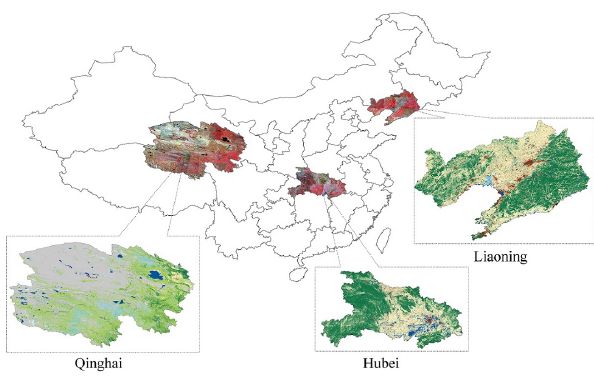
Figure 2. Locations of the study areas in